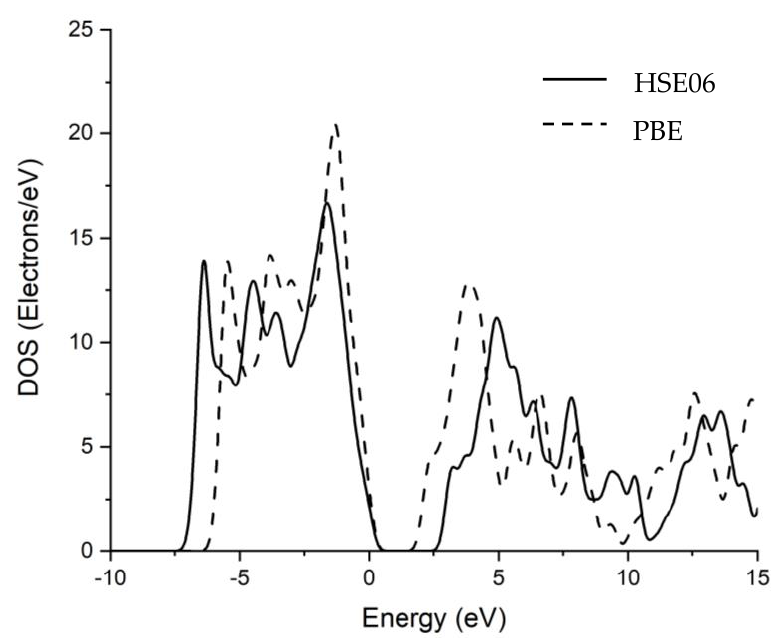
( b ) Figure 3. Band structure of MoO 3 calculated using PBE functional ( a ) and HSE06 hybrid functional ( b ). In the experiment carried out by [45], it was found that the band gap of MoO 3 was 3.2 eV. A 94.6% accuracy in the HSE06 hybrid functional and a 66.25% accuracy in the PBE functional were achieved by calculating the band gap of MoO 3 . Qian Qu [46] calculated